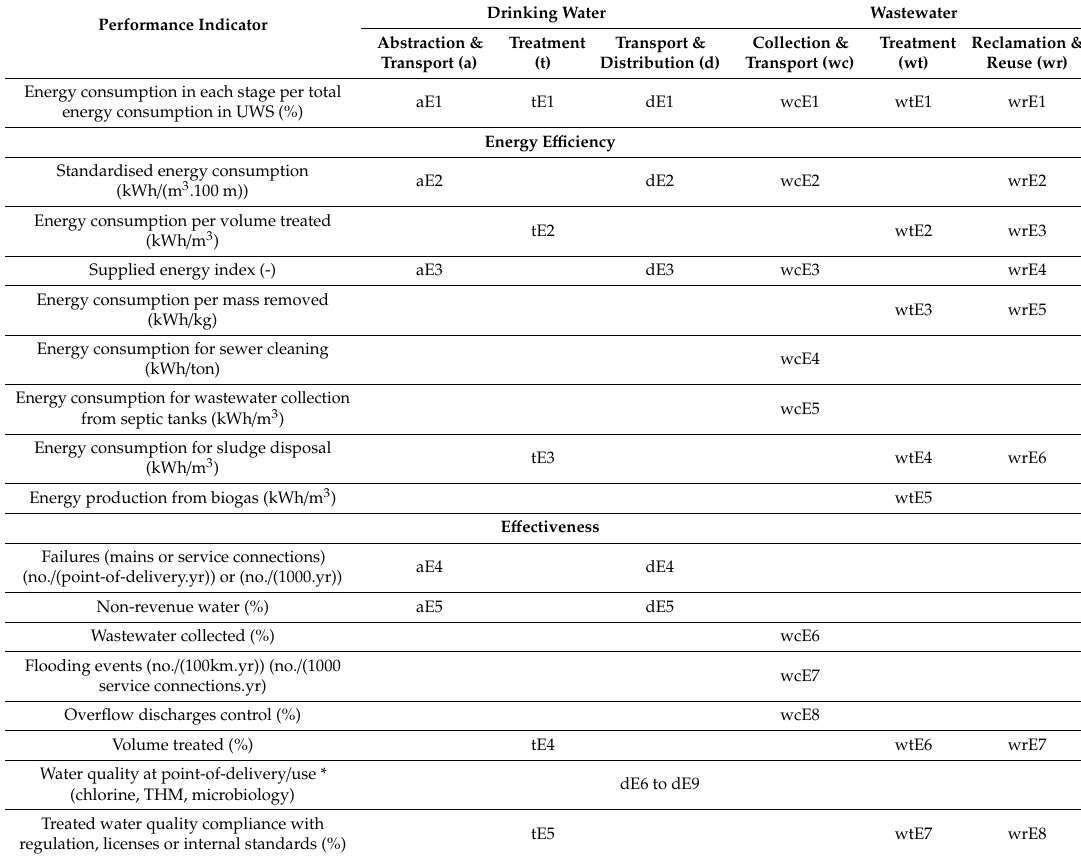
Table 1. Urban water systems (UWSs) performance assessment framework—PIs of energy e ffi ciency and e ff ectiveness per UWS stage and infrastructure